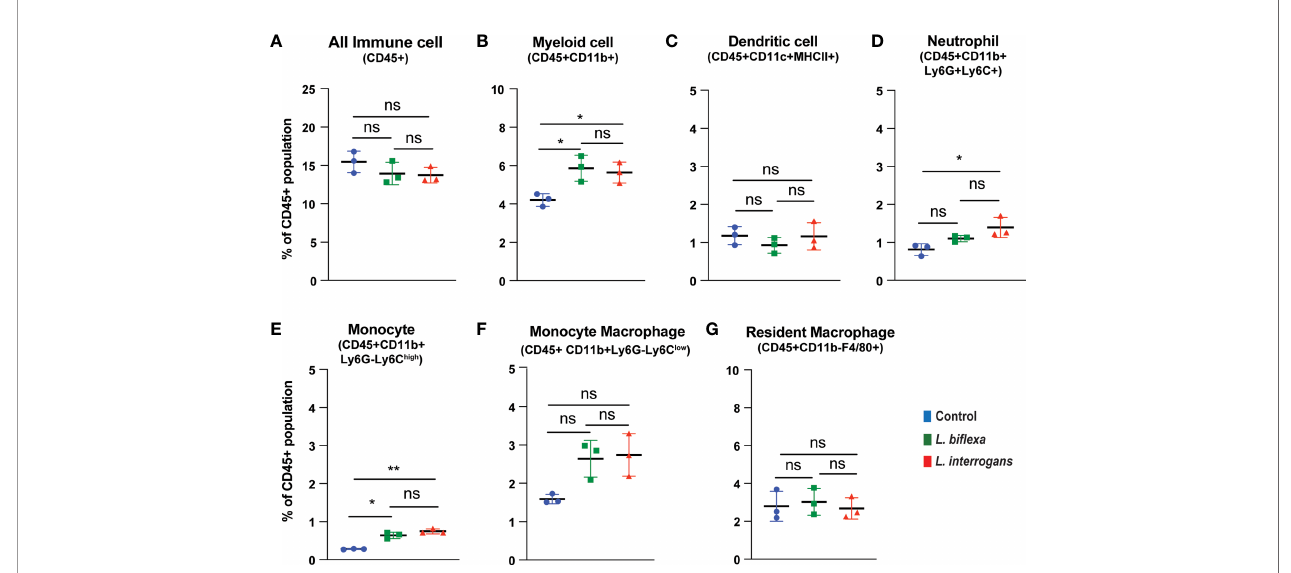
FIGURE 1 | Apoptotic cell death among different immune cells in spleen at 24h post infection. Annexin V + /Propidium Iodide (PI) - cells were considered as zone of apoptosis in (A) All Immune Cells, (B) Myeloid cell, (C) Dendritic cell, (D) Neutrophil, (E) Monocyte, (F) Monocyte-Macrophage and (G) Resident Macrophage. Plots are represented as % of CD45+ population. Statistical analysis was performed using unpaired student t-test with Welch ’ s correction, *p < 0.05, **p < 0.01; n = 3 mice per group. ns, not-signi fi cant. Data represents one of two independent experiments; N= 7 mice per